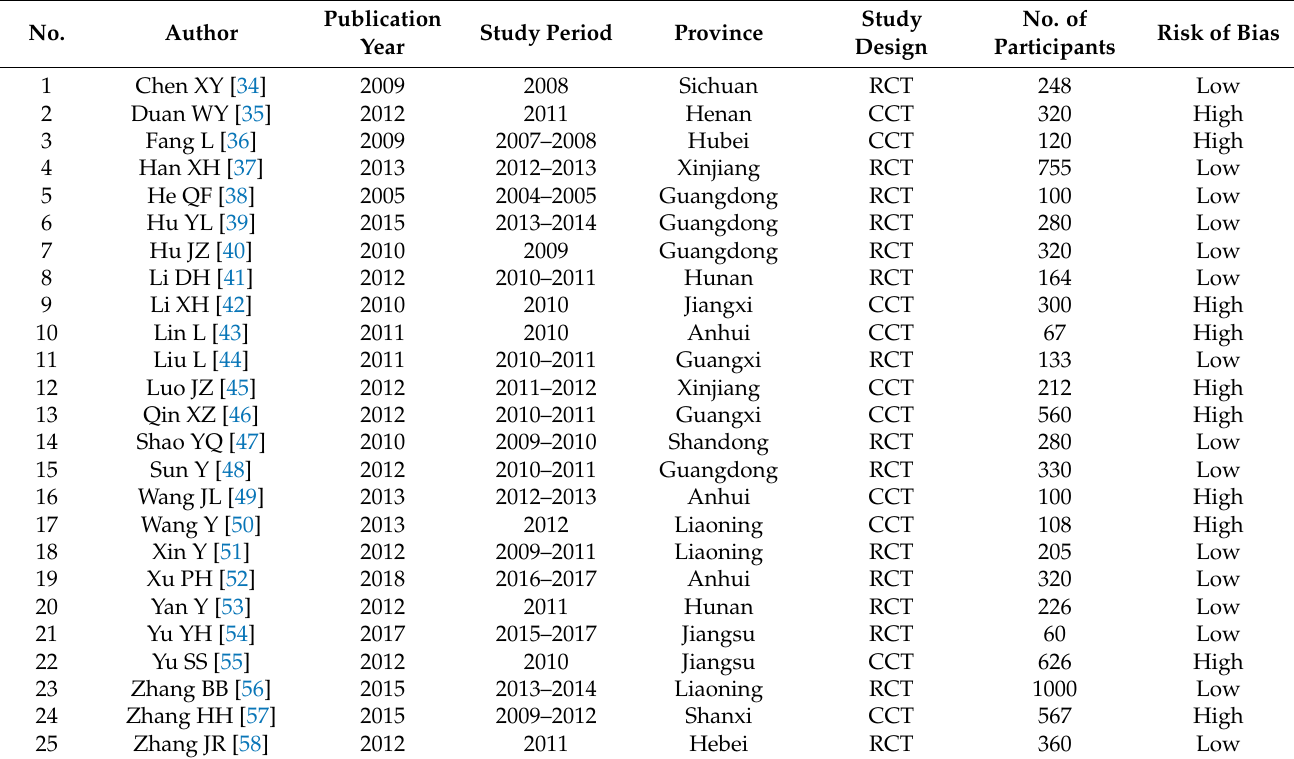
Table 1. Characteristics of studies included in this